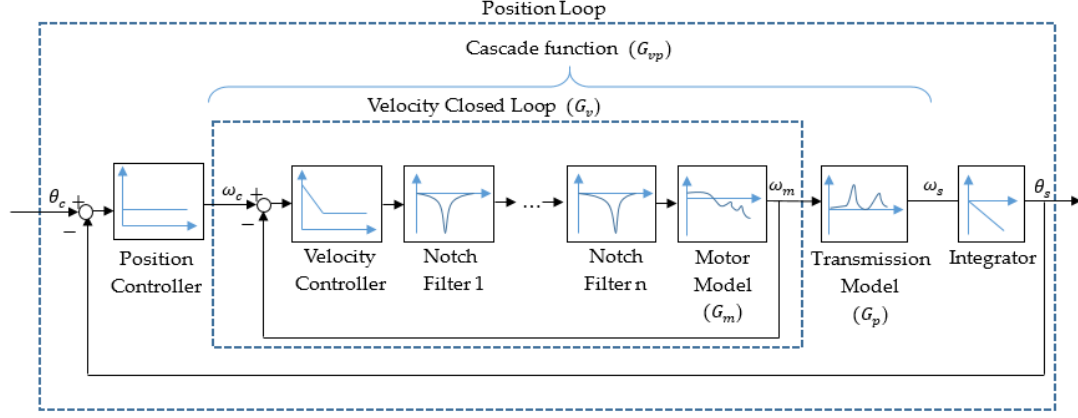
Figure 4. The transformed block diagram of the servo feed drive system.